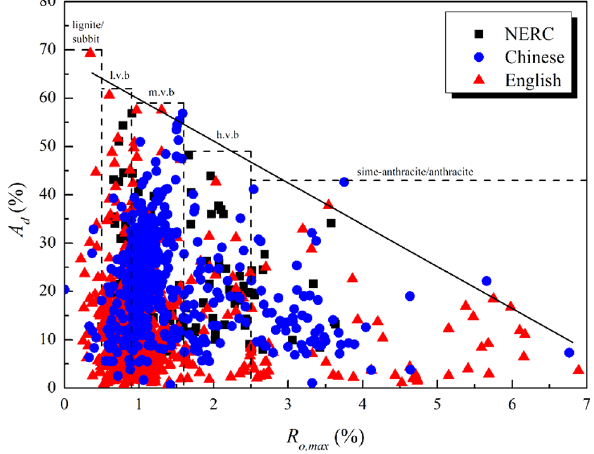
Fig. 7 Variation of A d with vitrinite reflectance R o ; max . (Data size: NERC-189, Chinese (Yu et al. 2004; Chang et al. 2006; Qin et al. 2007; Chang et al. 2008; Hao et al. 2012; Zheng 2012; Gao 2012; Jiang et al. 2012; Li et al. 2013; Lin et al. 2013; Xiao et al. 2016)-268, English, (Mahajan and Walker 1971; Joubert et al. 1973; Yalc¸in and Durucan 1991; DeGance et al. 1993; Chaback et al. 1996; Bustin and Clarkson 1998; Nodzen´ski 1998; Hildenbrand et al. 2006; Faiz et al. 2007a, b; Faiz et al. 2007; Yu et al. 2008a, b, c; Gensterblum et al. 2010; Taraba 2011; Wang